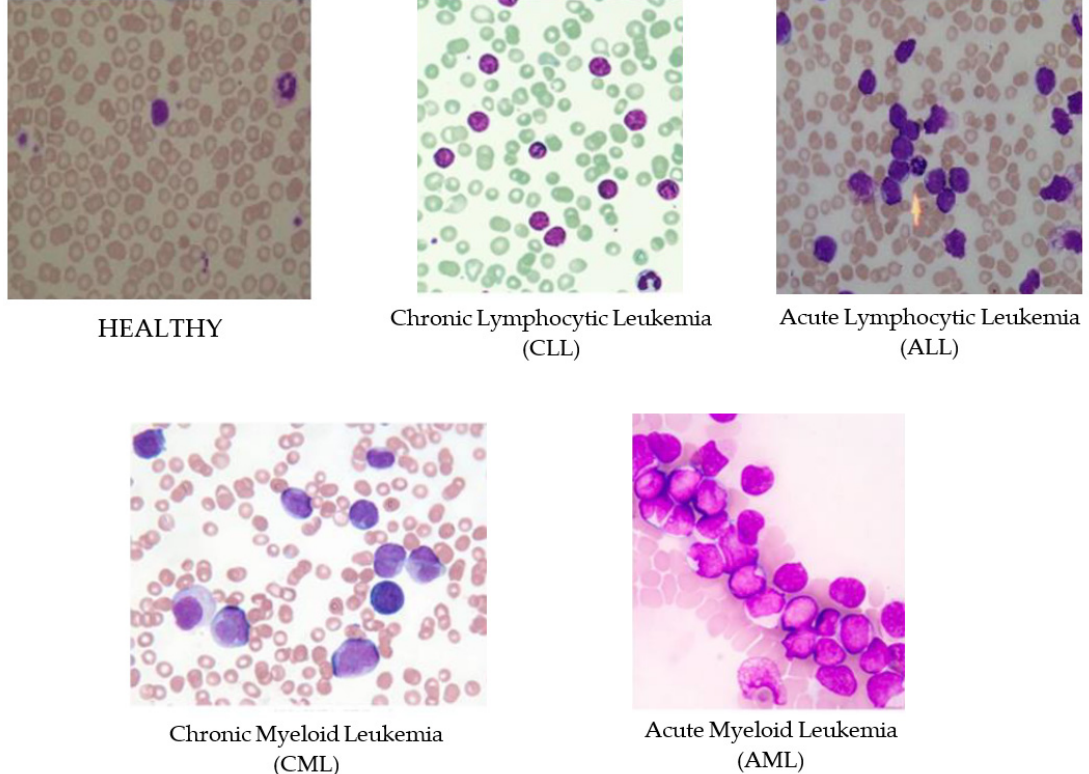
Figure 1. Sample images of four di ff erent types of Leukemia: Chronic Lymphocytic Leukemia (CLL) [8], Chronic Myeloid Leukemia (CML) [8], Acute Lymphocytic Leukemia (ALL) [8], Acute Myeloid Leukemia (AML) [8], and HEALTHY [5].